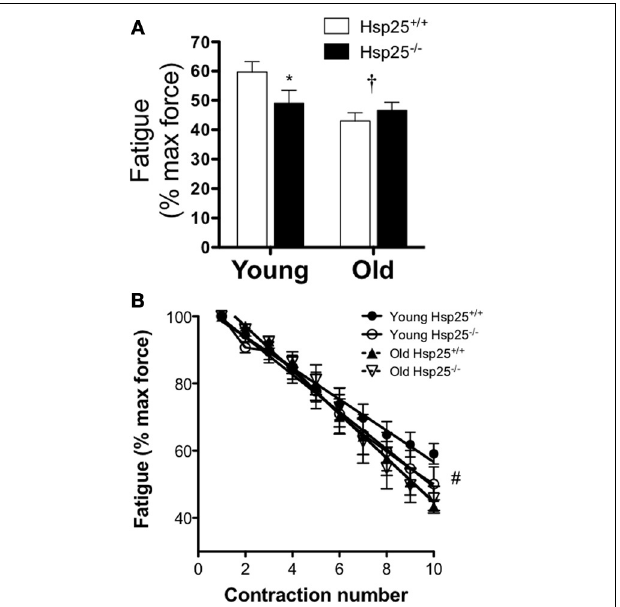
FIGURE 3 | Average plantarflexor fatigability (A) and rate of force decline (B) in young and old Hsp 25 + / + and Hsp 25 − / − mice. Fatigability was calculated as the % of maximal isometric force after 10 contractions with a contraction every 5s. (B) Average rate of force decline shows the % of maximal isometric force for all 10 contractions. ∗ Significantly different from young Hsp 25 + / + ( P = 0.046), † significant main effect of age ( P = 0.0093), # all groups significantly different from young Hsp 25 + / + ( P < 0 . 0001). Data are presented as means ± SE, n = 8 for all